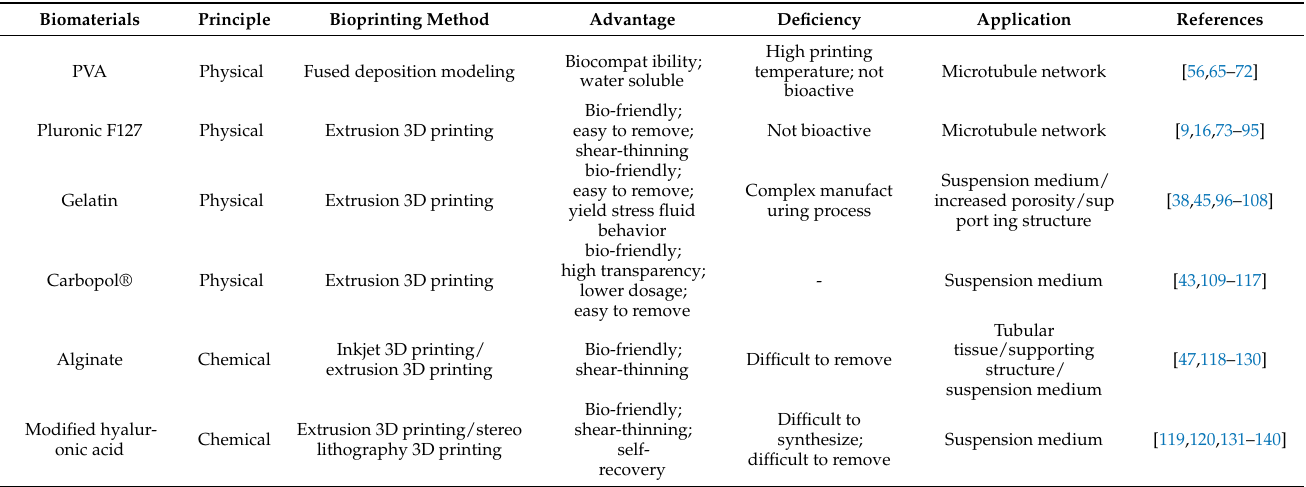
Table 1. Advantages and disadvantages of several commonly used sacrificial biomaterials for organ